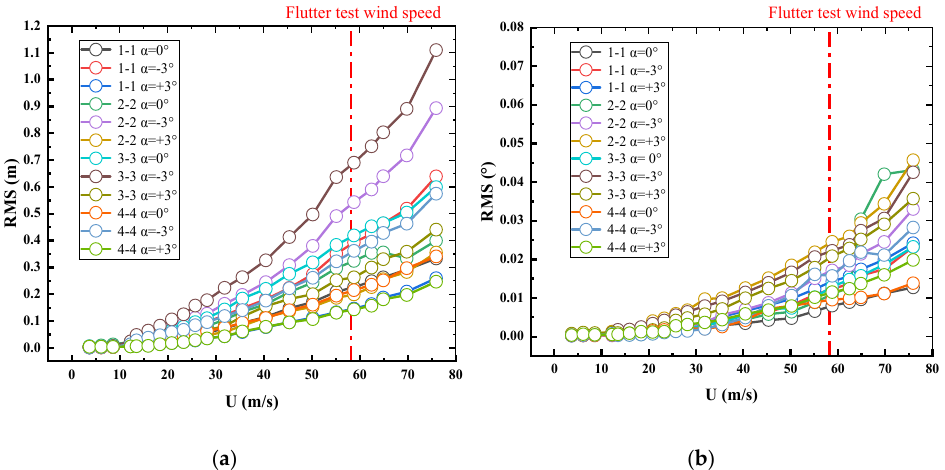
Figure 20. The root mean square (RMS) value of the displacement of each measure point of the service state in turbulent wind. ( a ) Vertical; ( b )